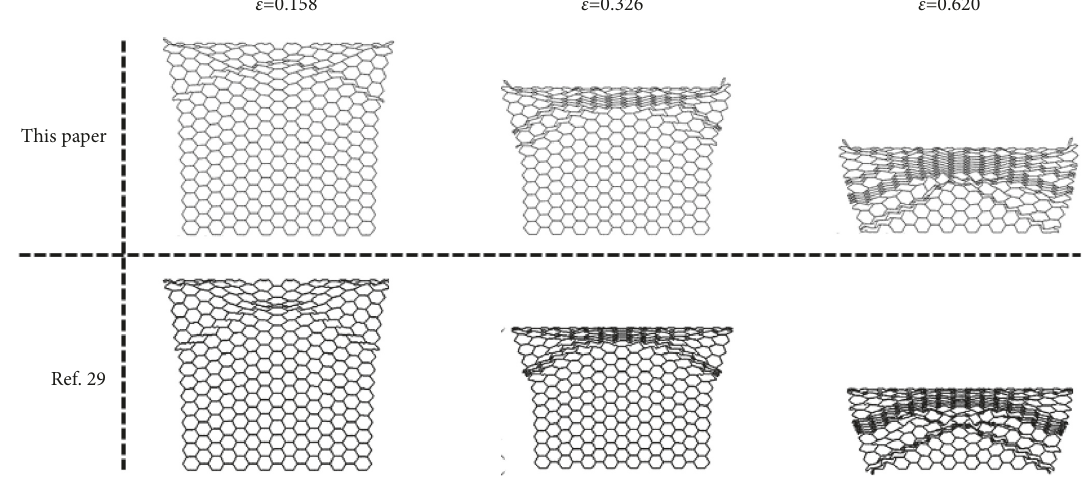
Figure 3: Comparison of deformation between the present finite element model and the results in [29].